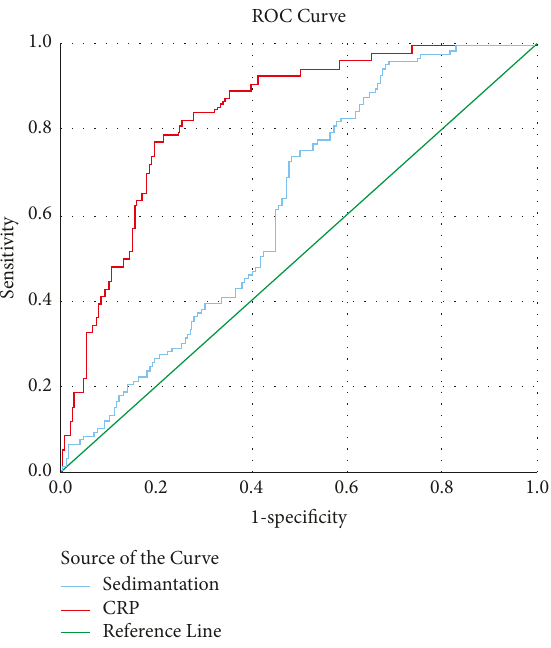
Figure 3: ROC curves for the prediction of intensive care needs by sedimentation and CRP. Table 5: Sensitivity and specificity values for CRP and